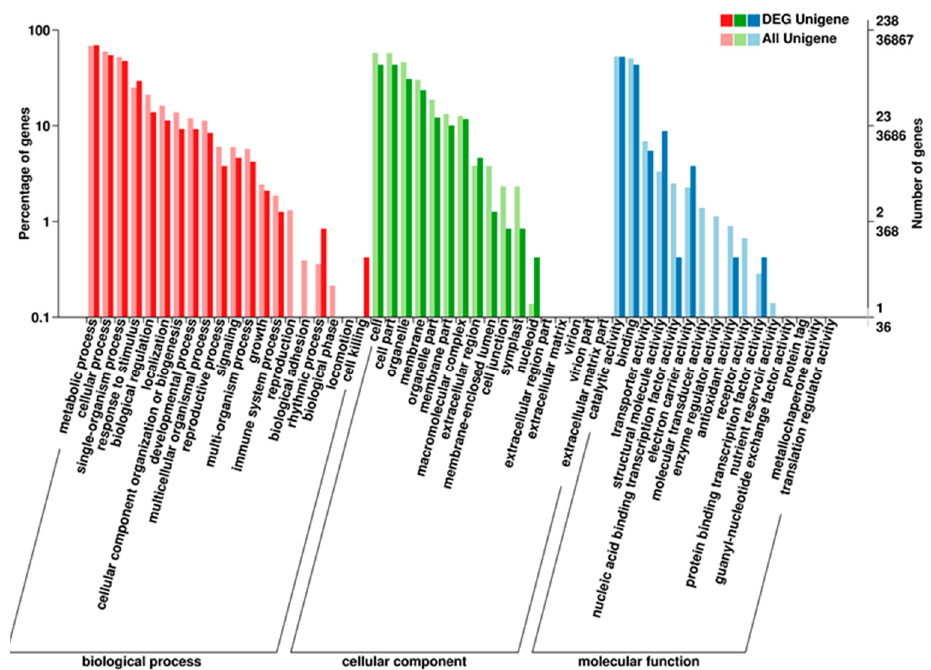
Figure 2. Gene Ontology (GO) classification of common differentially expressed genes (DEGs) that were detected in both comparisons of LT vs. CK and high light HL vs. CK in B. semperflorens leaves. LT, low temperature-treated plants; HL, high light-treated plants; CK, control plants.